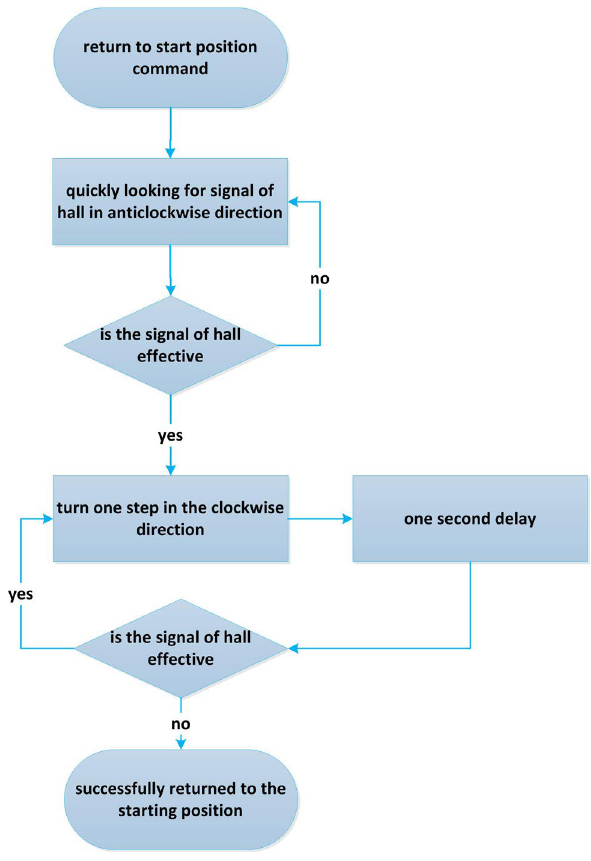
Figure 6. Control flow chart of turntable mechanism returning to the starting